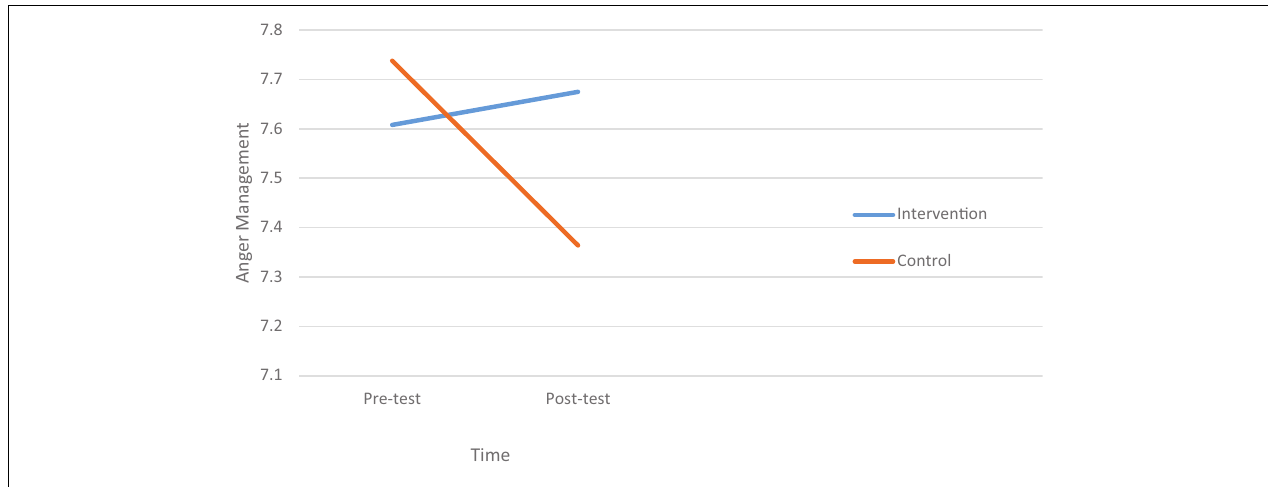
FIGURE 2 | A plot of the simple main effect of time for the intervention and control groups for anger coping.